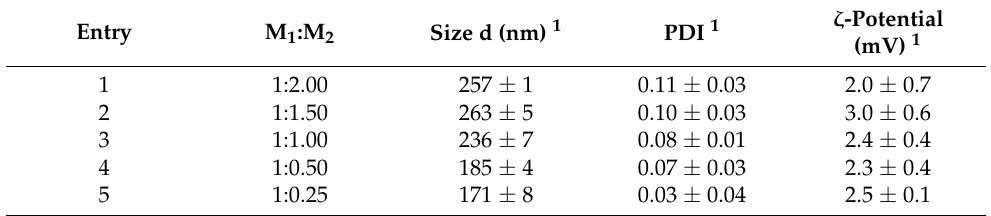
Table 1. Analysis of the tunability of the hydrodynamic diameter of NGs by varying the precursor ratios.